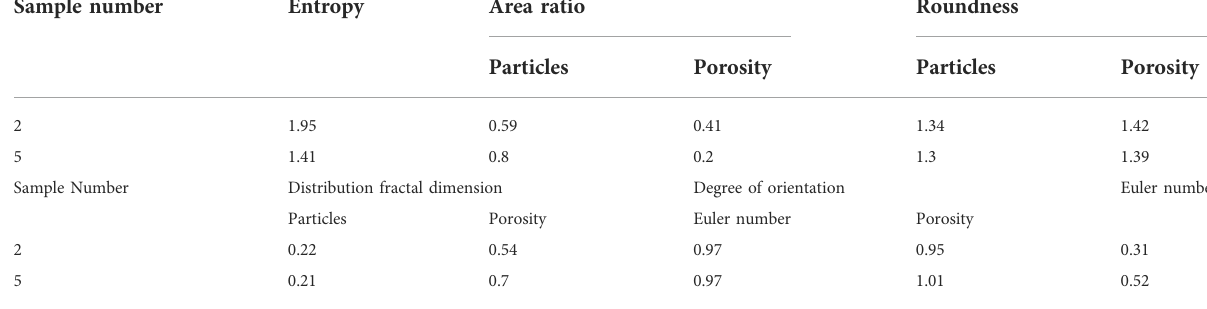
TABLE 5 Micro characteristic